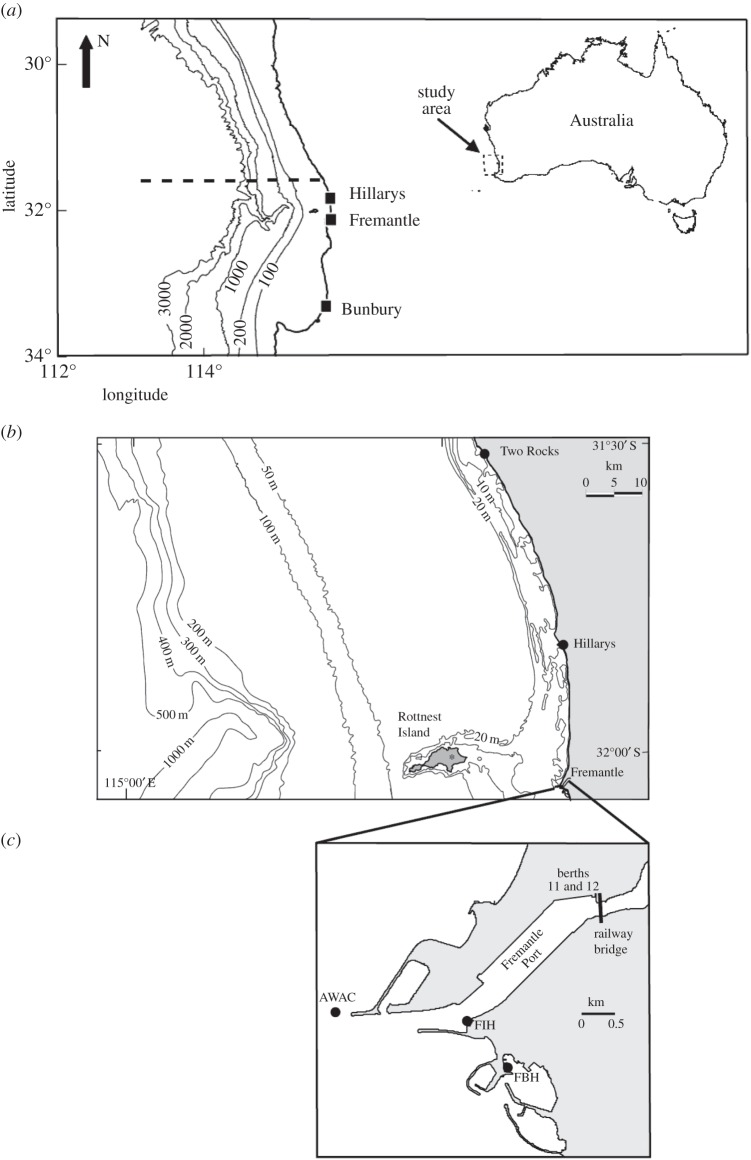
Maps showing the study region in southwest Australia with bathymetry in metres and locations of tide gauges (dots) and the meteorological station location at Rottnest Island (b). (a) Shows the numerical model extent. (c) Location of measurement stations in the vicinity of Fremantle Port. AWAC shows the location of current measurements. AWAC, acoustic wave and current; FBH, Freemantle Boat Harbour; FIH, Freemantle Inner Harbour.